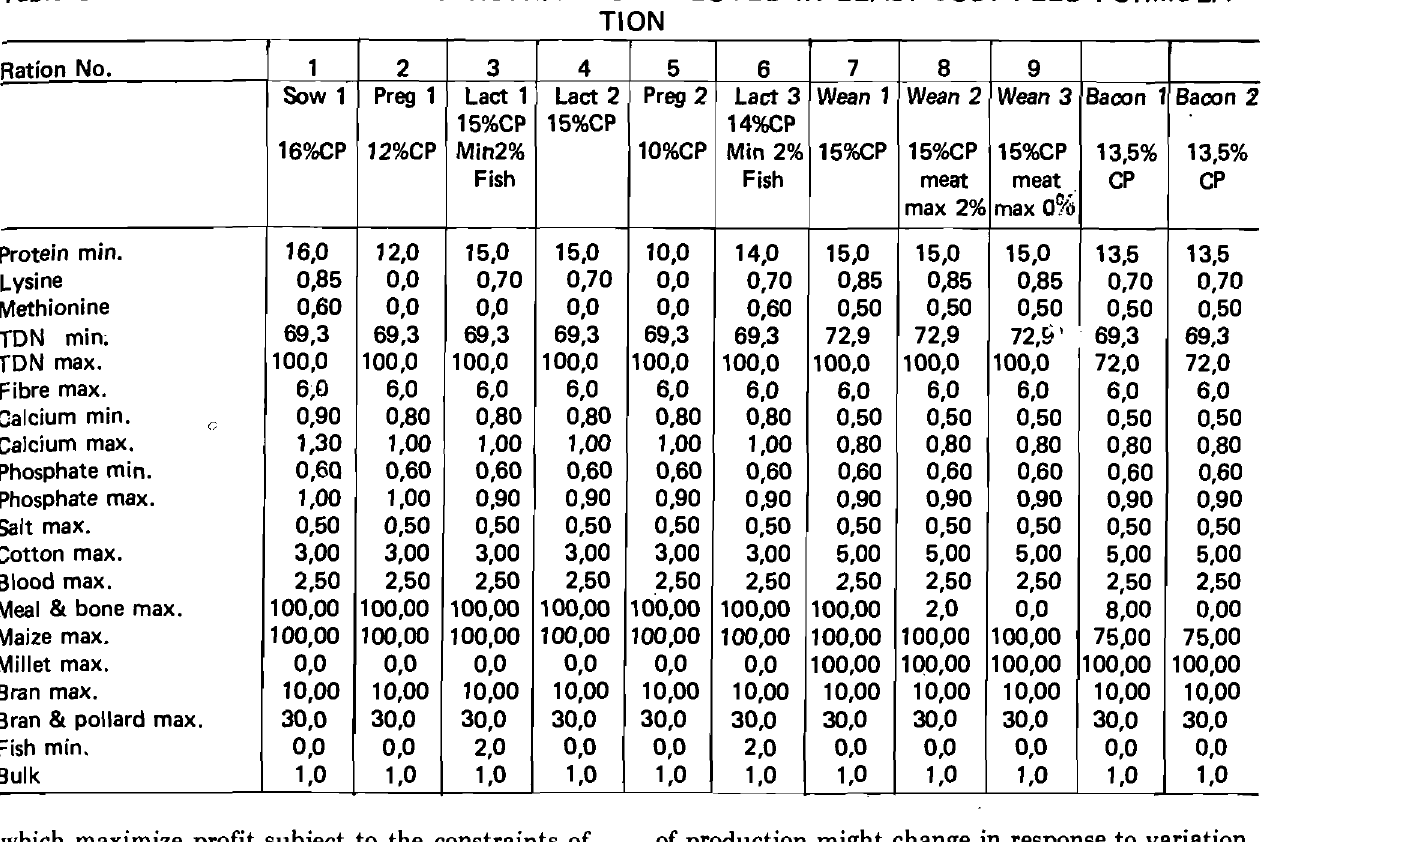
Table 3: MAXIMUM & MINIMUM CONSTRAINTS EMPLOYED IN LEAST COST FEED FORMULA Ration No.